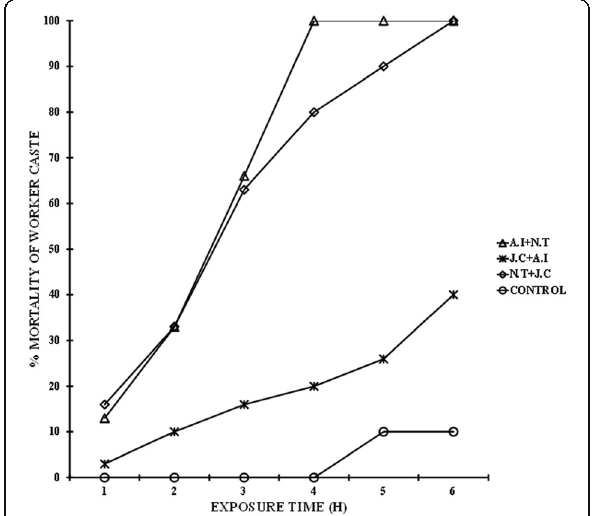
Fig. 1 Percentage mortality of worker caste of Macrotermes subhyalinus on filter papers treated with bi-mixed aqueous